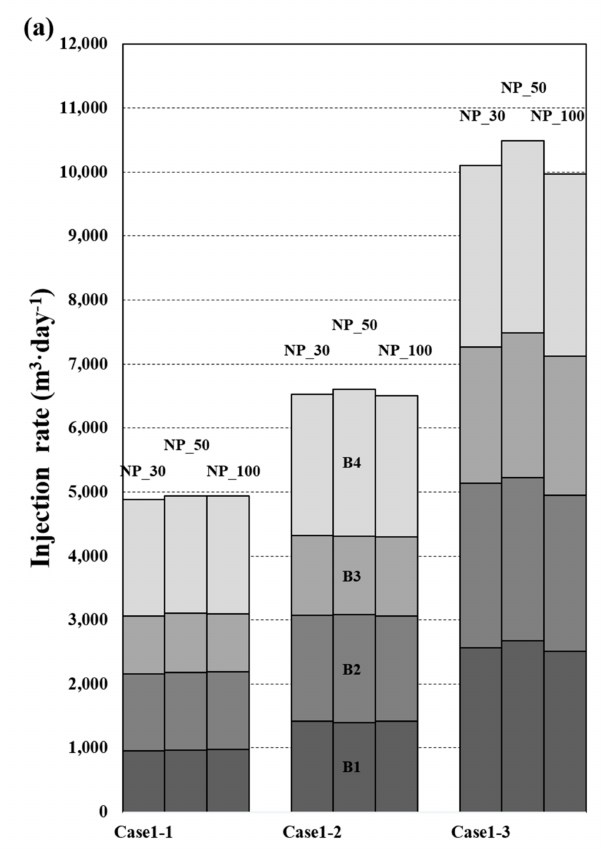
Figure 10. The averaged results from six times of repeated optimization processes for each different population size in management Scenario